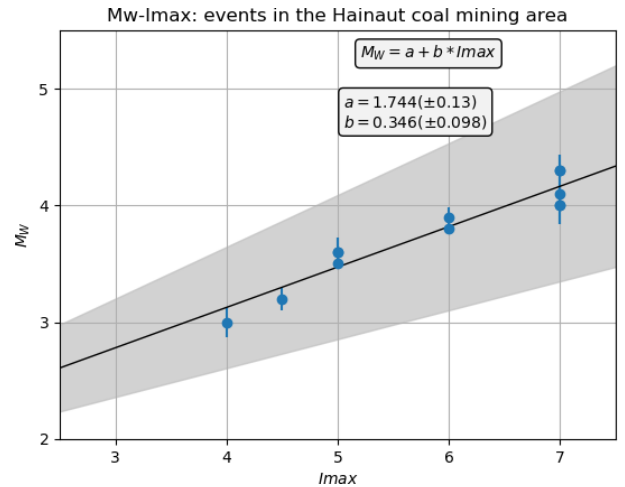
Figure 8. Relationship between M w and I max (approximation for I 0 ) determined for 12 calibration earthquakes in the Hainaut coal area (three data points are not visible because they are superim-